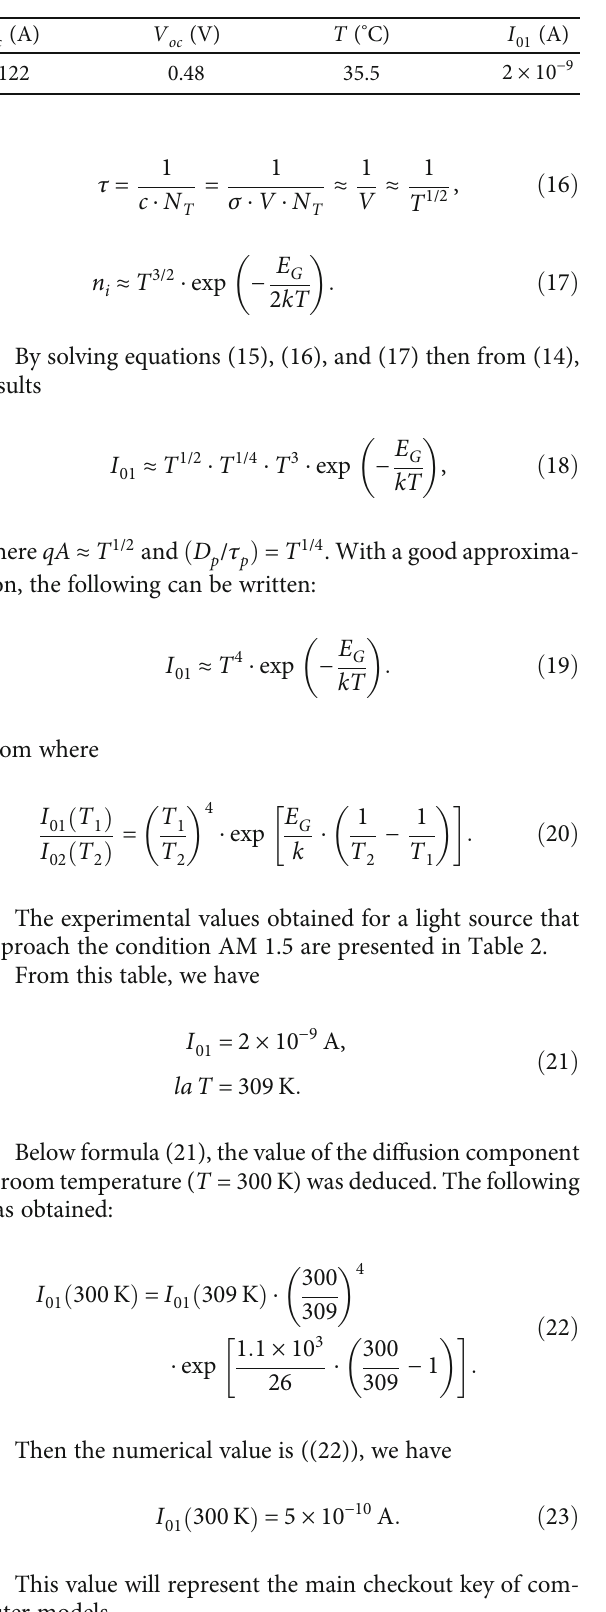
Table 2: Values obtained for a photovoltaic solar cell measured in condition AM